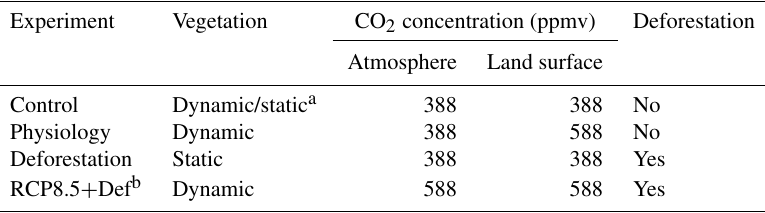
Table 1. Numerical experiments performed with CPTEC-BAM.